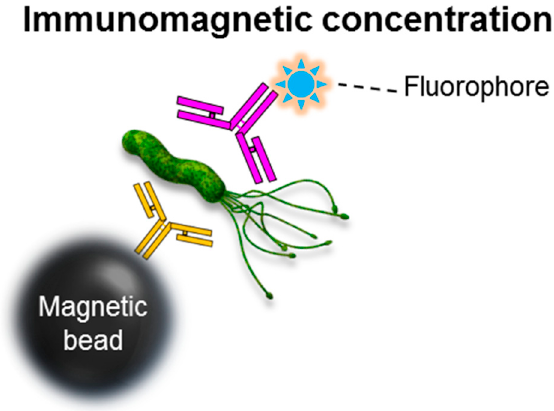
Figure 4. Schematic for magnetic, bead-assisted pathogen detection using fluorescence enhancement. The initial concentration of the pathogen in the food rinse or testing buffer can be increased using a simple immunomagnetic separation processes. This microbial detection tool utilizes paramagnetic beads and the antibodies specific to the target food pathogen. The magnetic bead and target cell complex can be separated from the food suspension with a magnet and transferred to a cuvette for fluorescent detection.